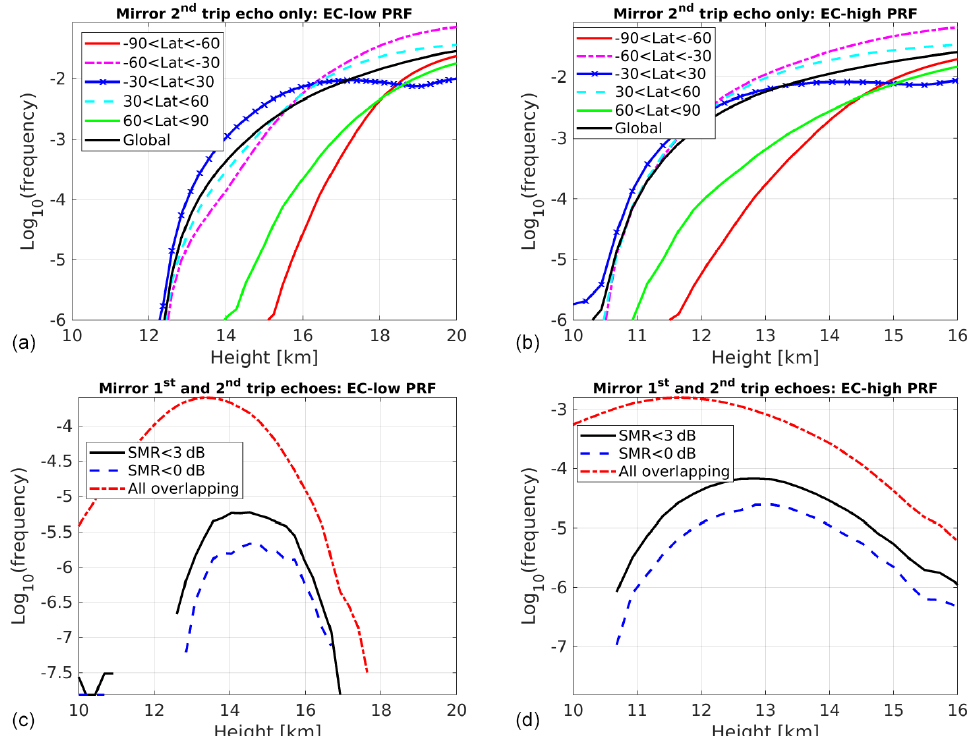
Figure 9. Simulated frequency of second-trip echoes alone (a, b) and for coincident second- and first-trip echoes (c, d) both above the minimum detection threshold for the low-PRF (a, c) and high-PRF (b, d) EarthCARE configurations. In panels (c) and (d) , three curves are presented corresponding to signal-to-mirror ratios (SMRs) lower than 0 and 3dB (dashed blue and continuous black lines, respectively) or for any SMR (dot-dashed red